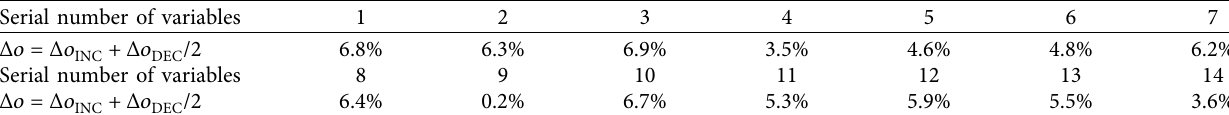
Table 2: Probability changes of food quality and safety source tracing variables.